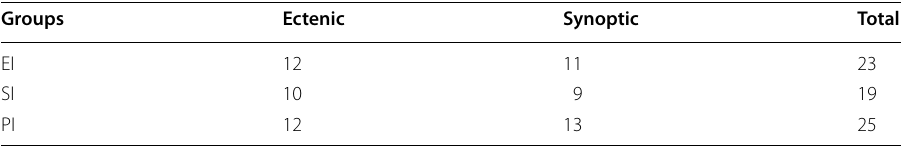
Table 1 Number of ectenic and synoptic participants in groups